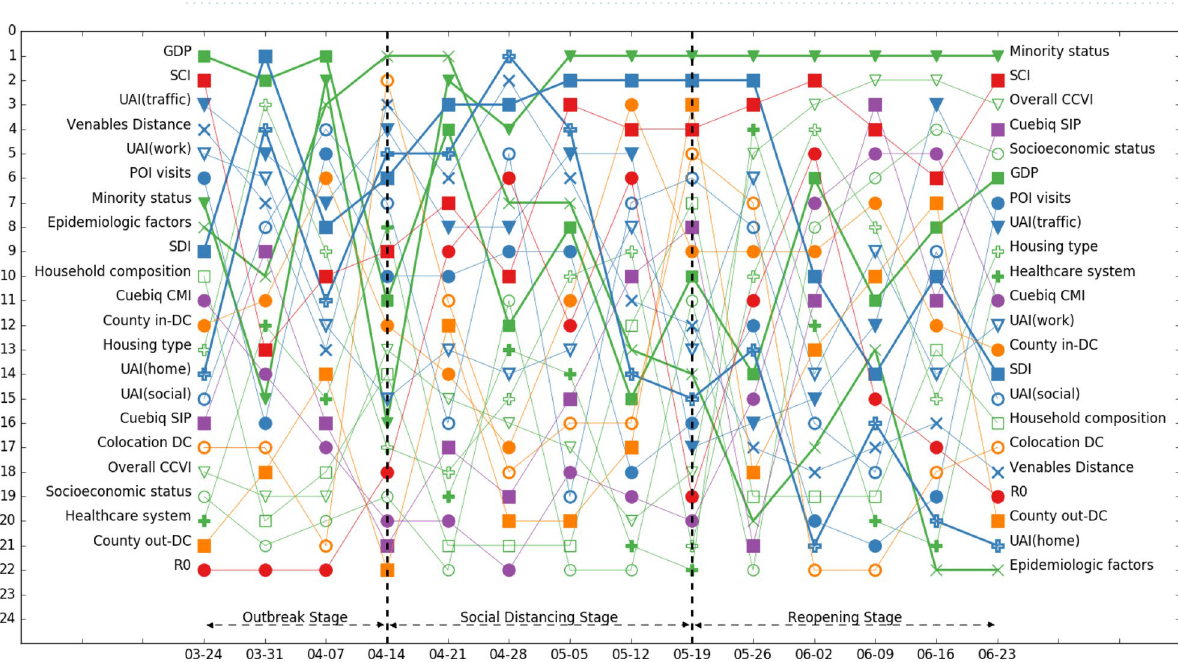
Figure 7. Rank of feature importance of model 5 throughout three stages of COVID-19. Social distance index shows high importance in counties with low population densities. Social demographic features have high importance in counties with low population